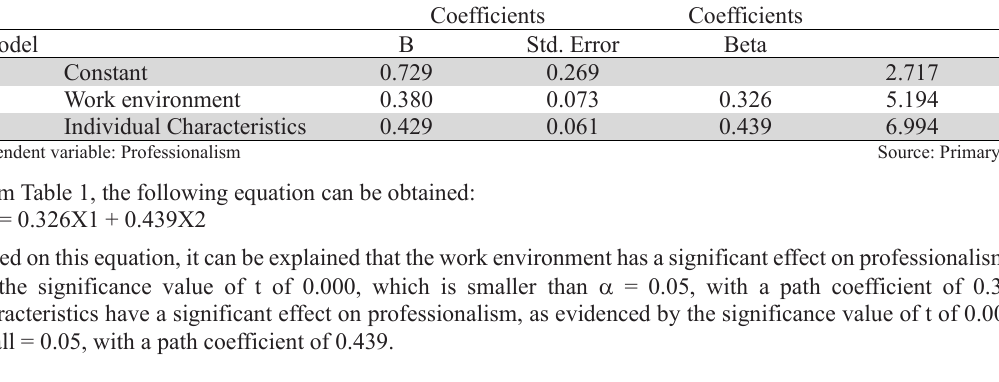
The Path Coefficient Test Results from the Work Environment and Individual Characteristics to Professionalism Unstandardized